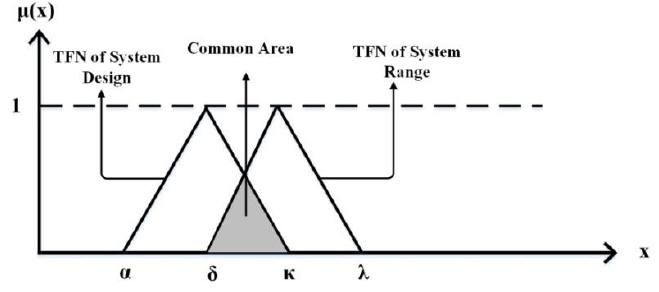
Figure 3. The common area of system and design ranges